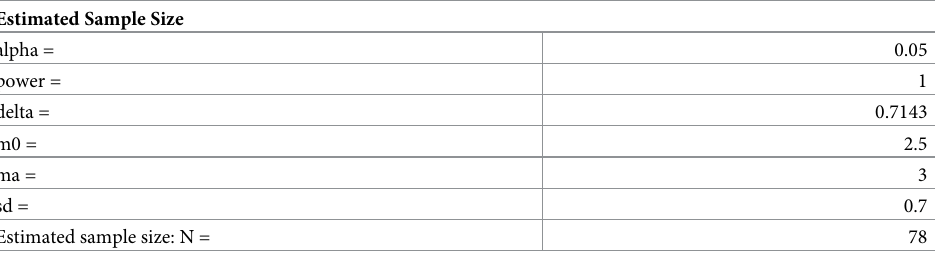
Table 2. Estimated sample size.